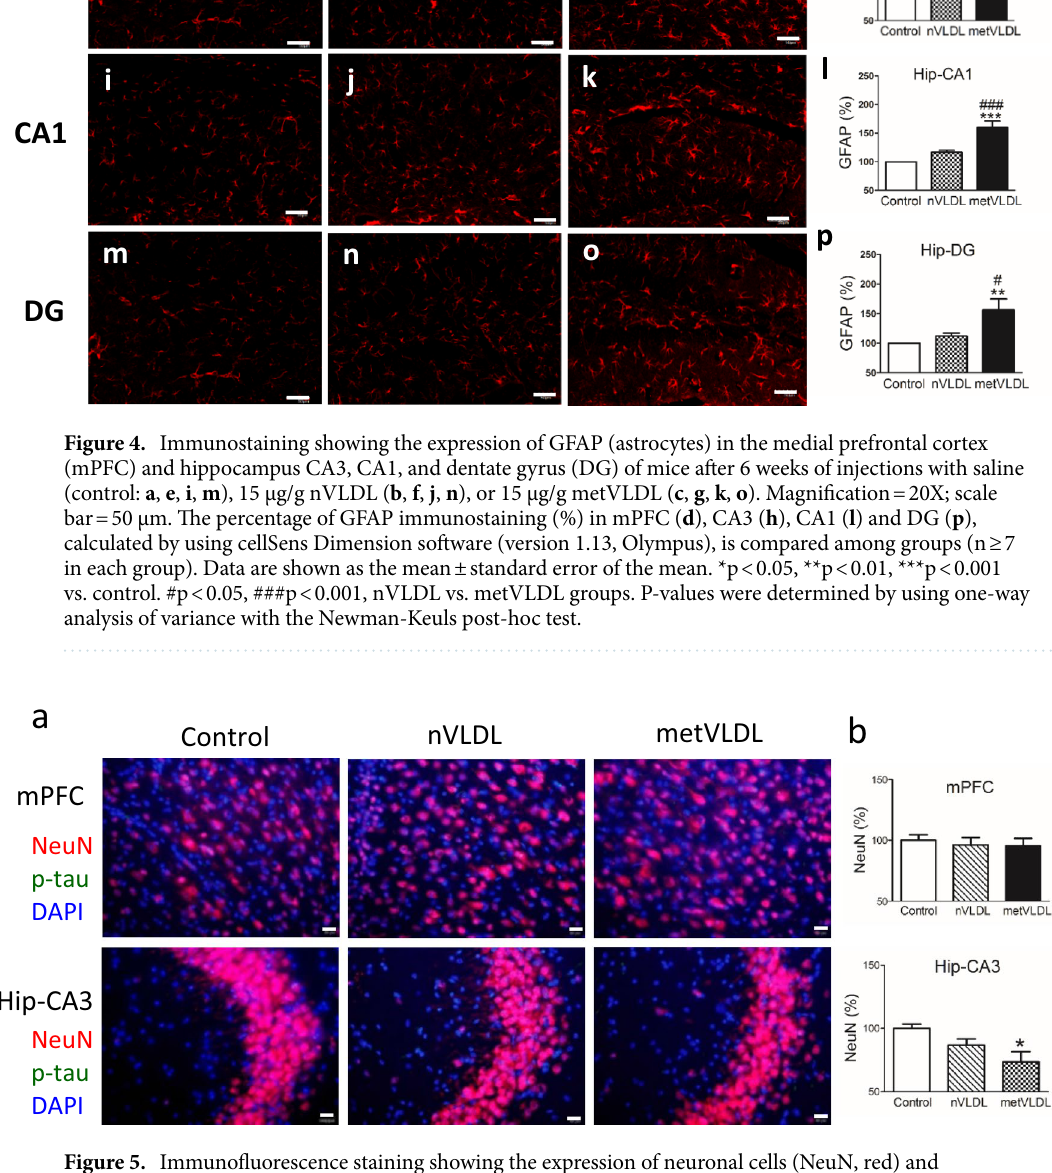
Figure 5. Immunofluorescence staining showing the expression of neuronal cells (NeuN, red) and phosphorylated tau (p-tau, green) in the ( a ) medial prefrontal cortex (mPFC) and hippocampus CA3 (Hip-CA3) of mice after 6 weeks of injections with saline (control), 15 μg/g nVLDL, or 15 μg/g metVLDL. Magnification = 40X; scale bar = 20 μm. ( b ) The percentage of NeuN immunostaining (%) in the mPFC and hippocampus CA3, calculated by using cellSens Dimension software (version 1.13, Olympus), is compared among groups (n ≥ 4 in each group). Data are shown as the mean ± standard error of the mean. *p < 0.05 vs. control. P-values were determined by using one-way analysis of variance with the Newman-Keuls post-hoc